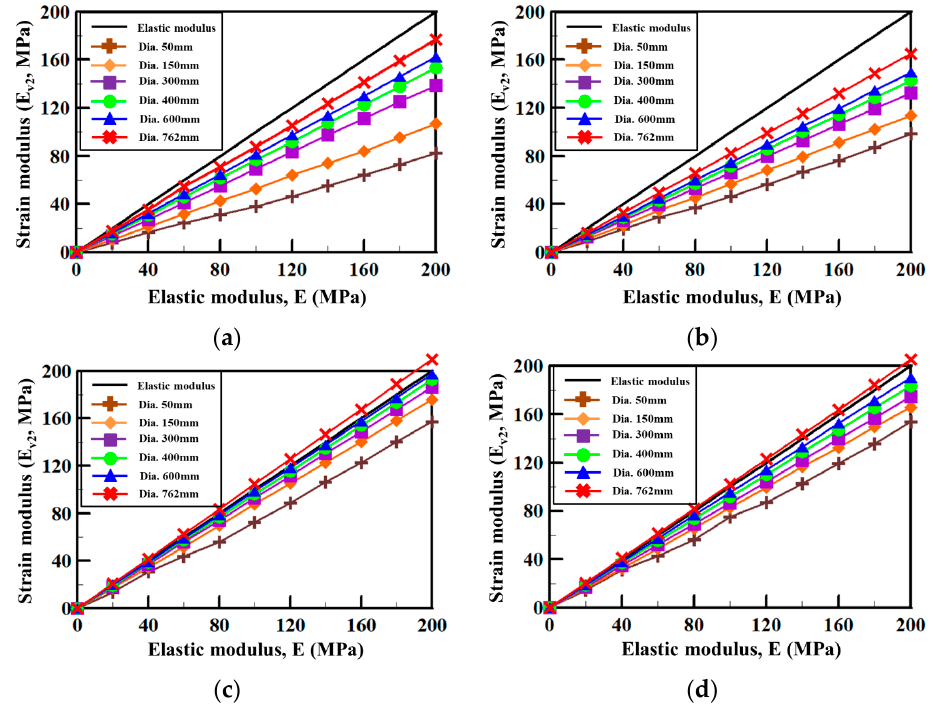
Figure 8. Relationship between the subgrade strain and elastic moduli according to the loading-plate size: ( a ) gravel and fine gravel; ( b ) sand; ( c ) sandy soil; ( d ) cohesive soil.